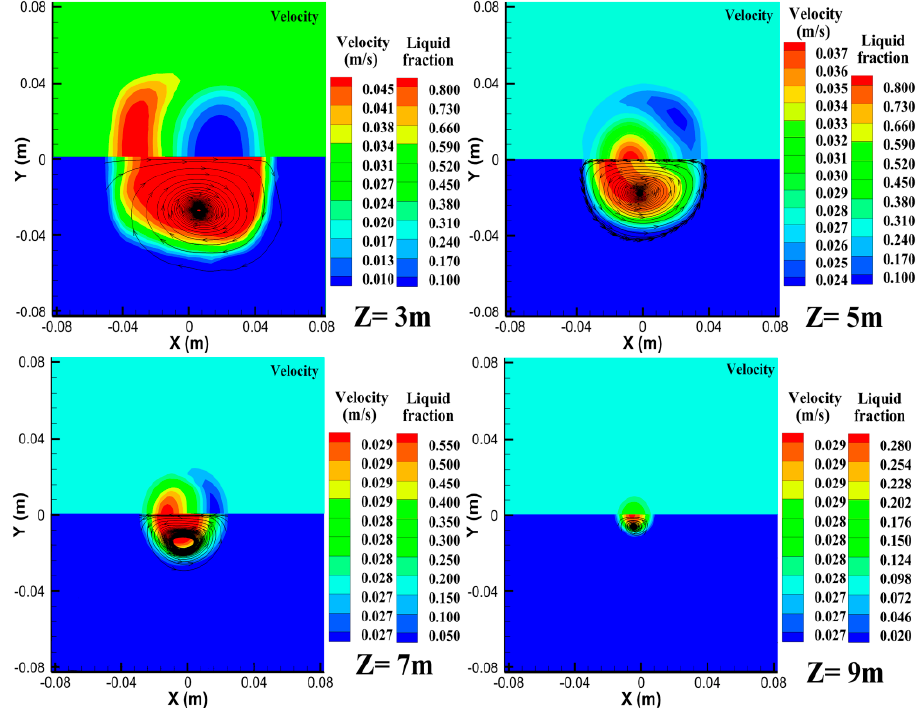
Figure 6. Contour plots of velocity and liquid fraction at different cross sections.